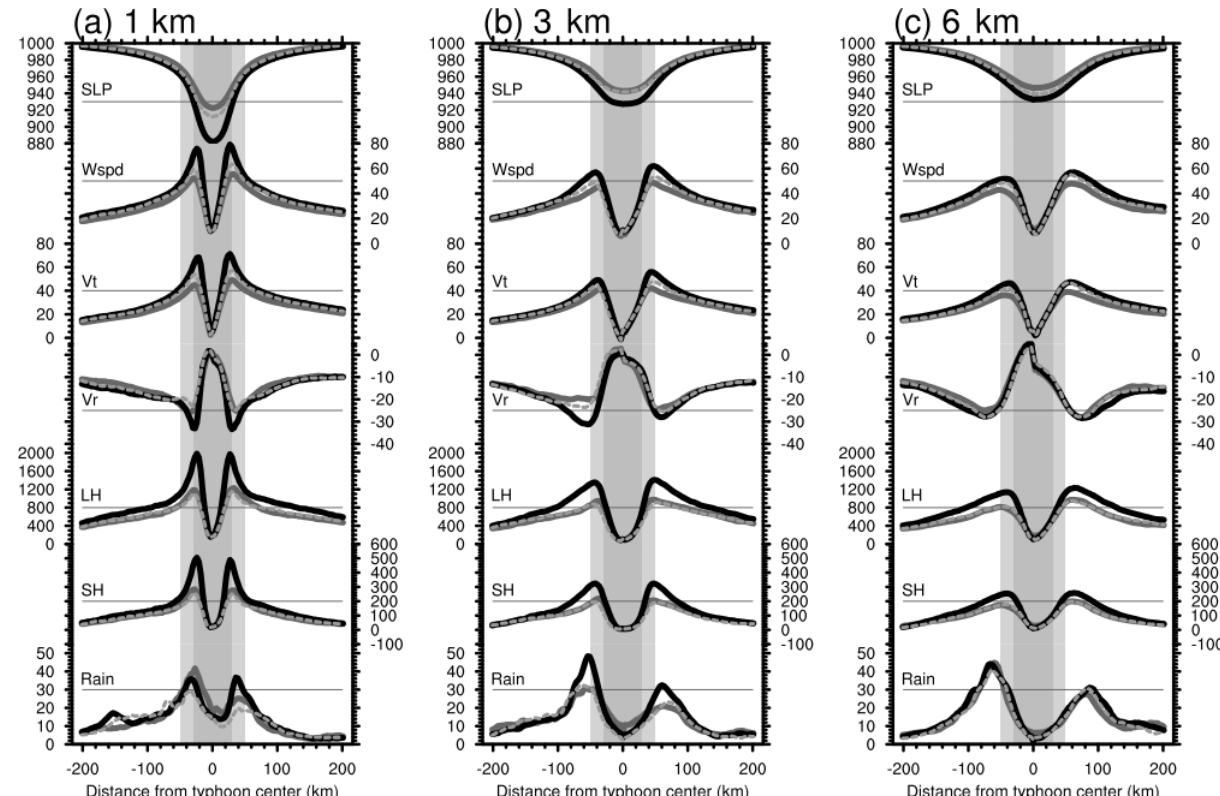
Figure 8. The radial variations of surface fields for experiments 1km (a) , 3km (b) , and 6km (c) . The surface fields shown are (from top to bottom) sea level pressure (SLP; hPa), wind speed and tangential and radial winds at 10m (Wspd, Vt, and Vr; ms − 1 ), surface latent and sensible heat fluxes (LH and SH; Wm − 2 ), and total rainfall (Rain; mmh − 1 ). Positive values of Vr indicate inflow. Gray, black, and gray-dashed curves represent flux options F0, F1, and F2, respectively. Horizontal gray lines are selected reference lines for each field. All fields are time averaged between 18:00UTC on 7 November 2013 and 00:00UTC on 8 November 2013. Positive and negative distances represent the right (northern) and left (southern) semicircles as in Fig. 7. Vertical light-gray and gray shaded bars denote the radial sectors bounded by radii of 50 and 30km,